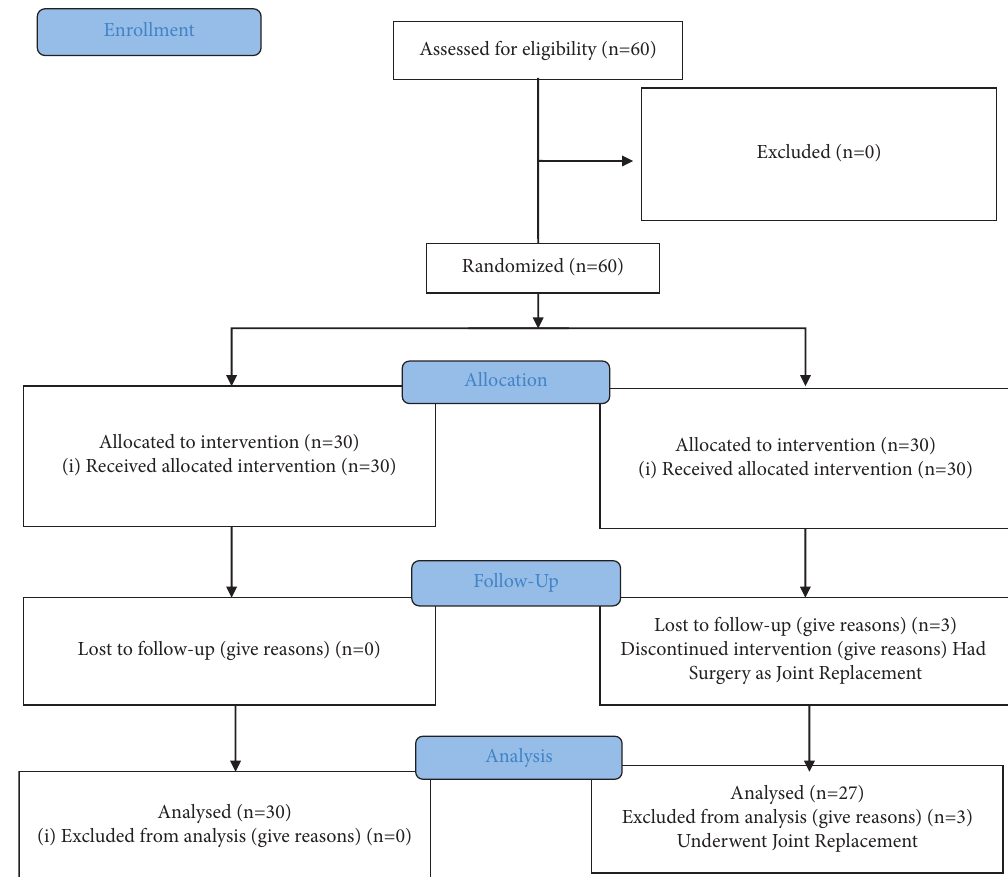
Figure 1: CONSORT flow diagram.